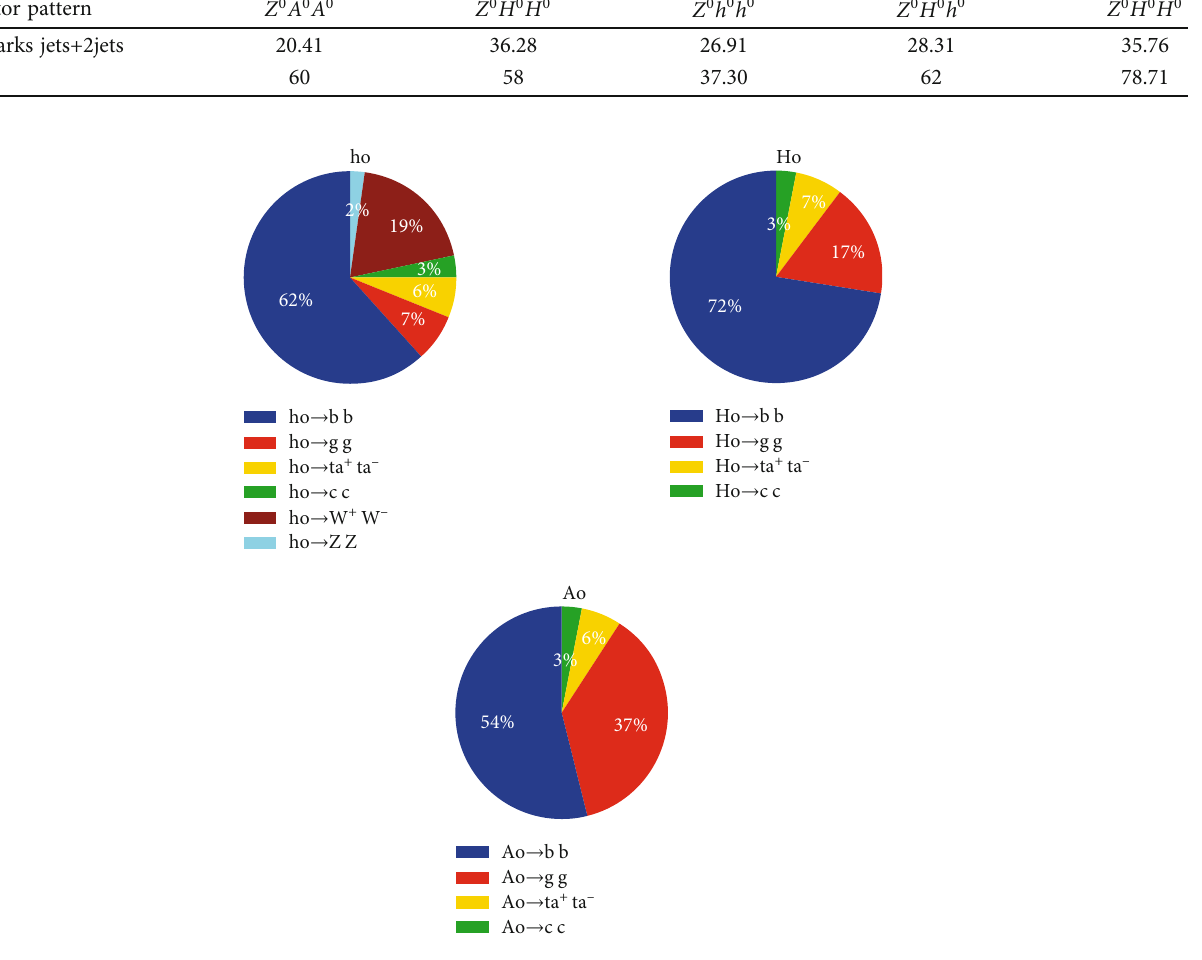
Figure 19: The branching ratios of all neutral Higgs boson decays for parameters de fi ned in Table 6. Table 7: Expected number of events calculated at di ff erent integrated luminosities, 1 ab − 1 and 3 ab − 1 . Detector